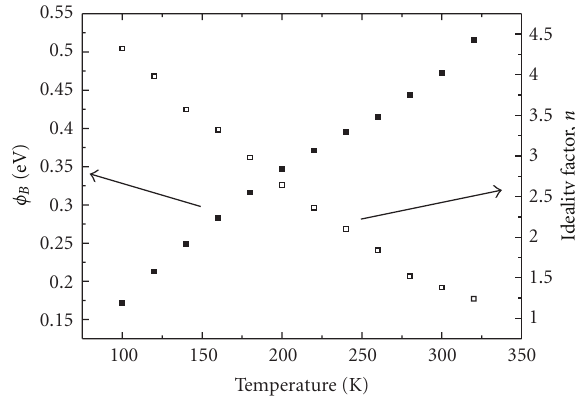
Figure 3: Temperature dependence of the ideality factor and barrier height for the Al/HfO 2 /p-Si (MOS) structure.